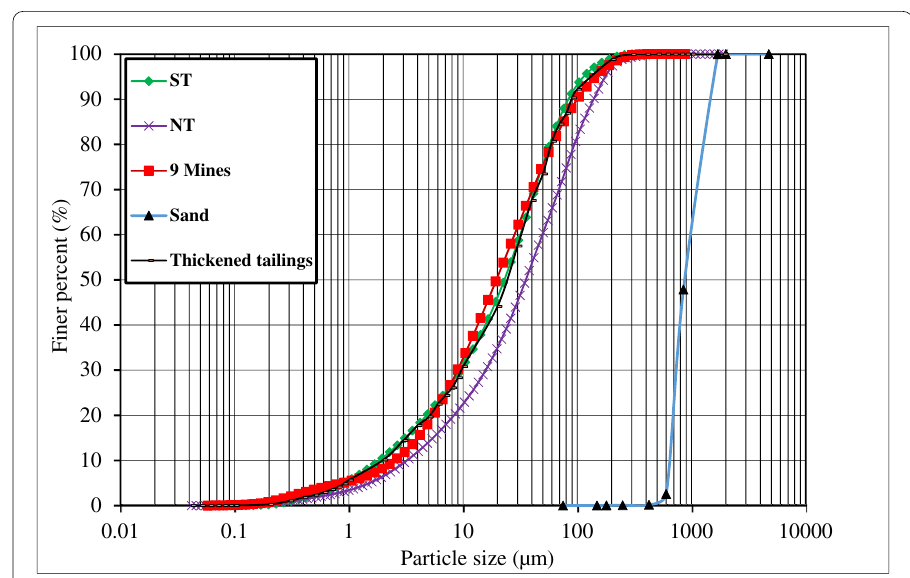
Fig. 1 Particle size distribution of the tailings and coarse-grained sand used in this work compared with the average of 9 eastern Canadian mine